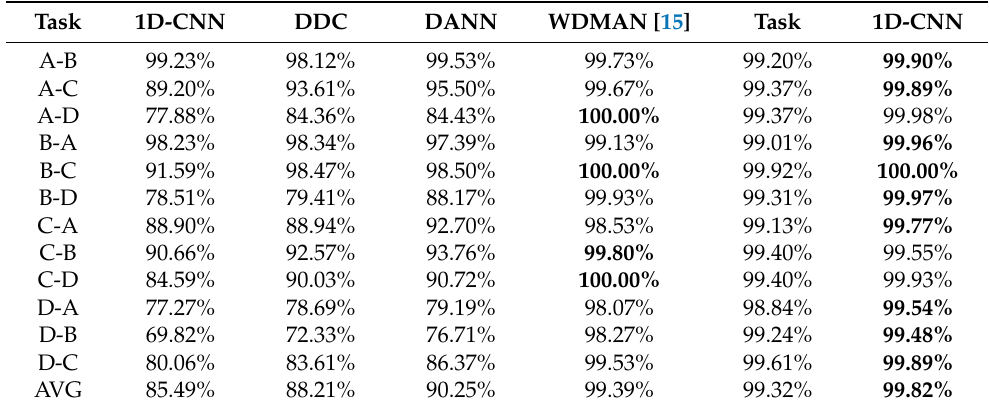
Table 5. Classification accuracies of the different methods on the CWRU dataset. The numbers in bold indicate the highest classification accuracy in corresponding task.